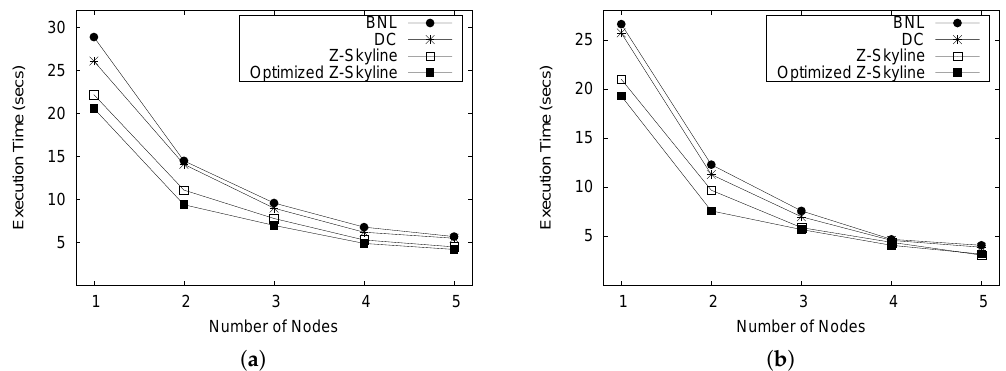
Figure 28. Profitable-area query performance by nodes. ( a ) NewYork ; ( b ) Chicago